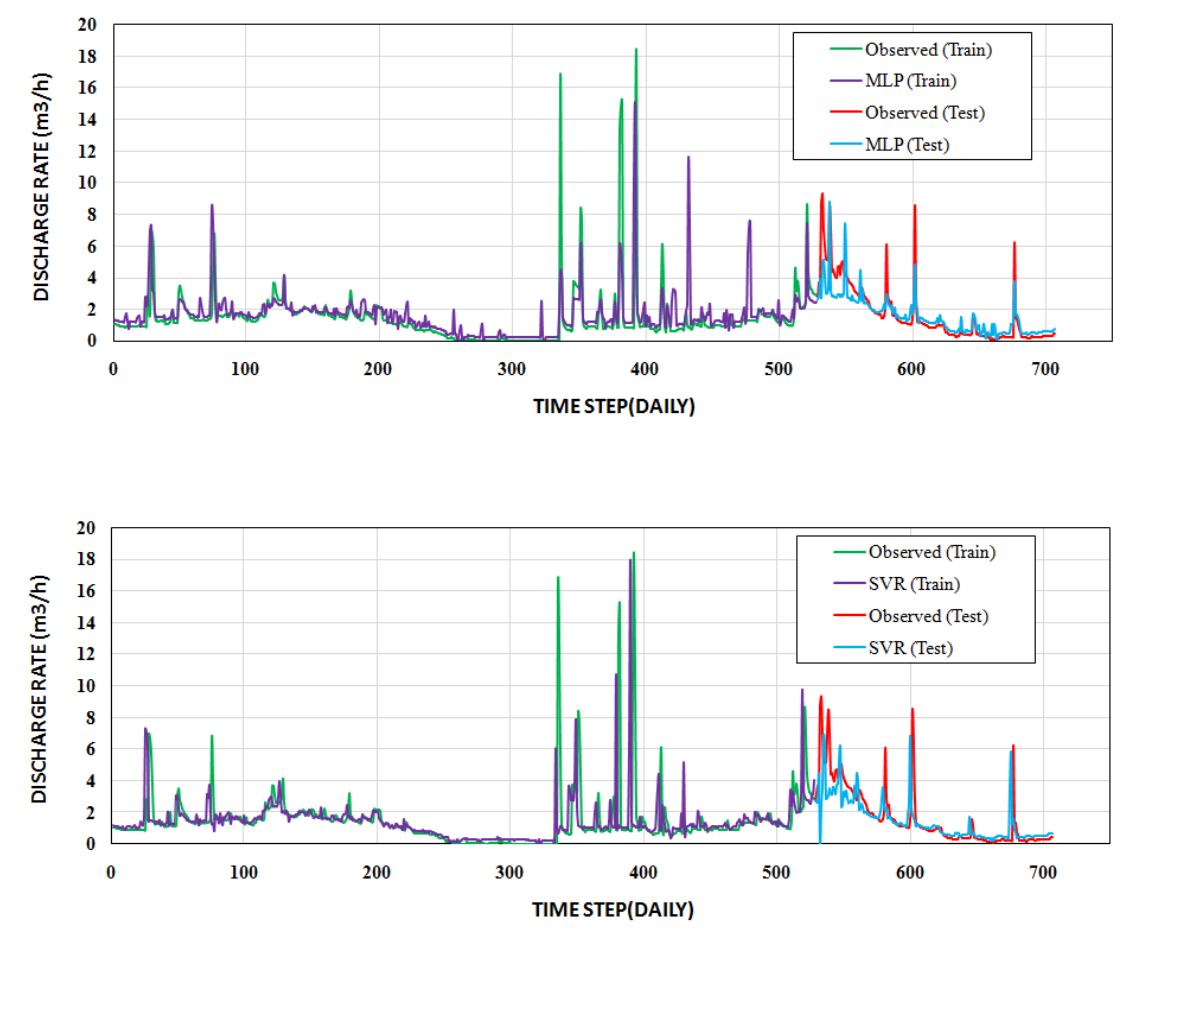
Figure 5: The simulated time series of the flow by models of MLP and SVR according to TRMM satellite data the SVR model has simulated the amount of the flow rate more than Figure 6 shows the time series simulated using data of TRMM 3B42RT observed values of simulation. This has less happened in the accuracy satellite. The peak values during calibration period have been verification underestimated than the observed values in most cases. Also, in most cases